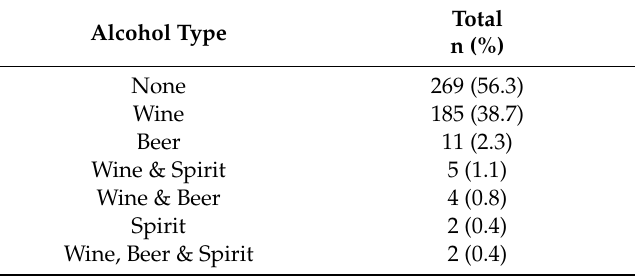
Table 3. Distribution of alcohol types in the